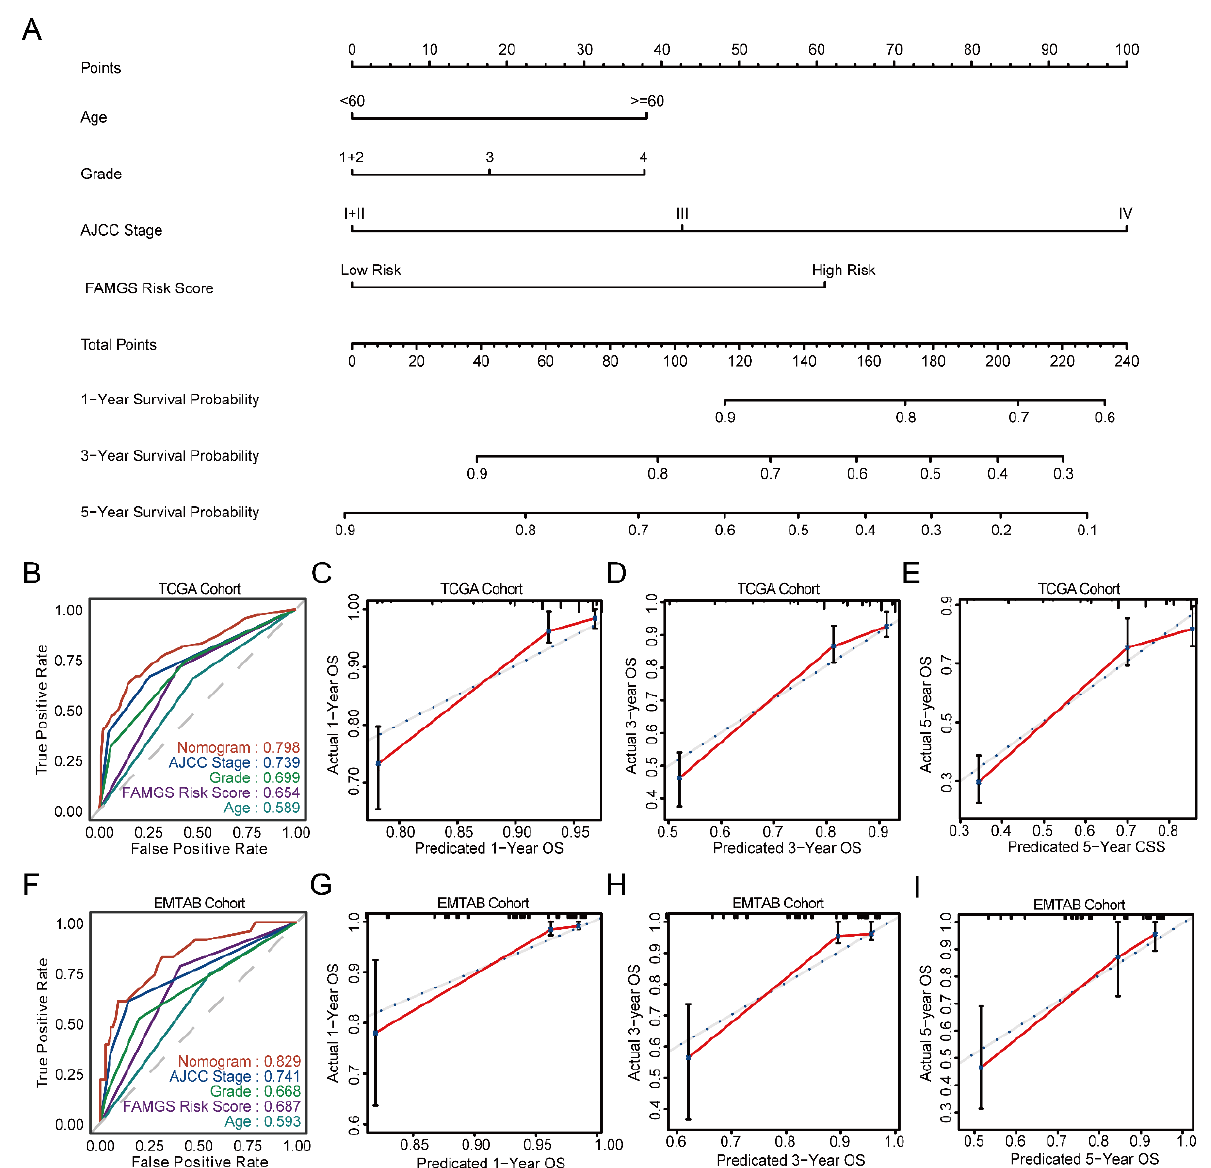
Figure 6. Construction and validation of a nomogram of OS for ccRCC patients. ( A ) Nomogram for predicting the probability of 1-, 3- and 5-year OS for ccRCC patients. Time-dependent ROC curves of the nomogram, the FAMGS, age, tumor grade and AJCC stage in the TCGA training cohort ( B ) and EMTAB validation cohort ( F ). Calibration plots of the nomogram for predicting the probability of OS at 1, 3 and 5 years in the TCGA training cohort ( C – E ) and EMTAB validation cohort ( G – I ).